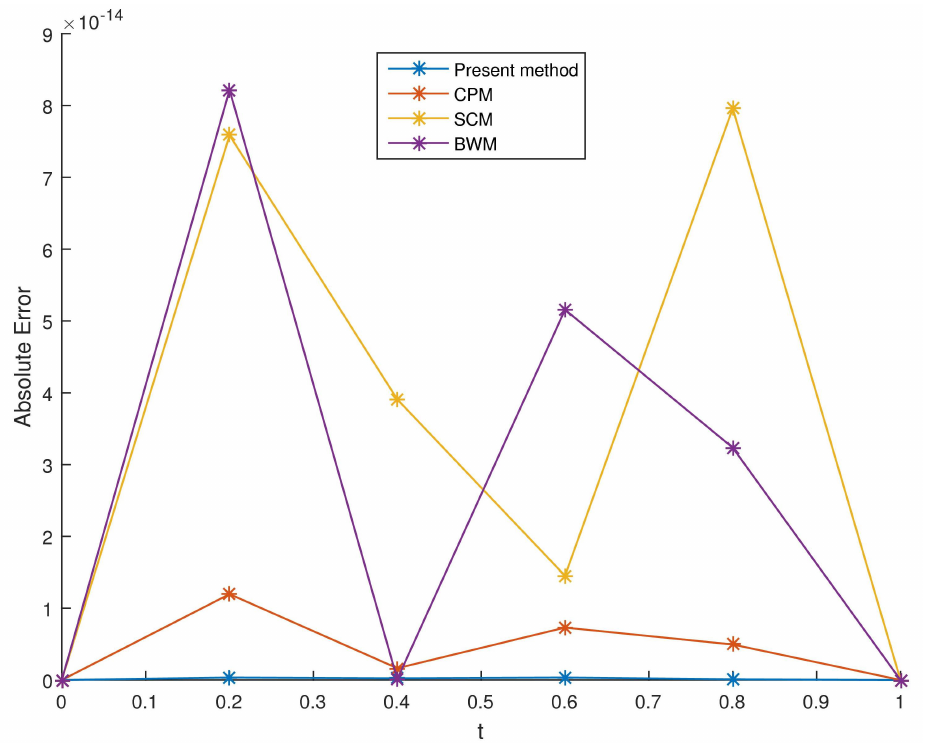
Figure 3. The graphical comparison of absolute errors acquired by our method, CPM, SCM and BWM, respectively.